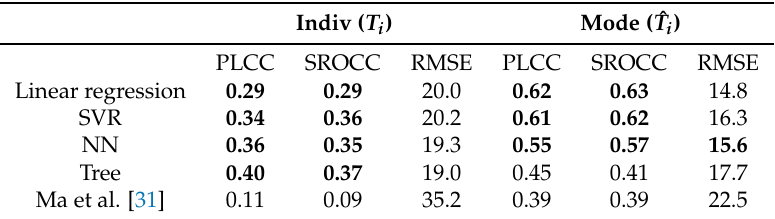
Table 2. Prediction performance of model (average of 100 random 70/30 splits). Correlation coefficients in bold font are not significantly different from each other column-wise ( p < 0.01).